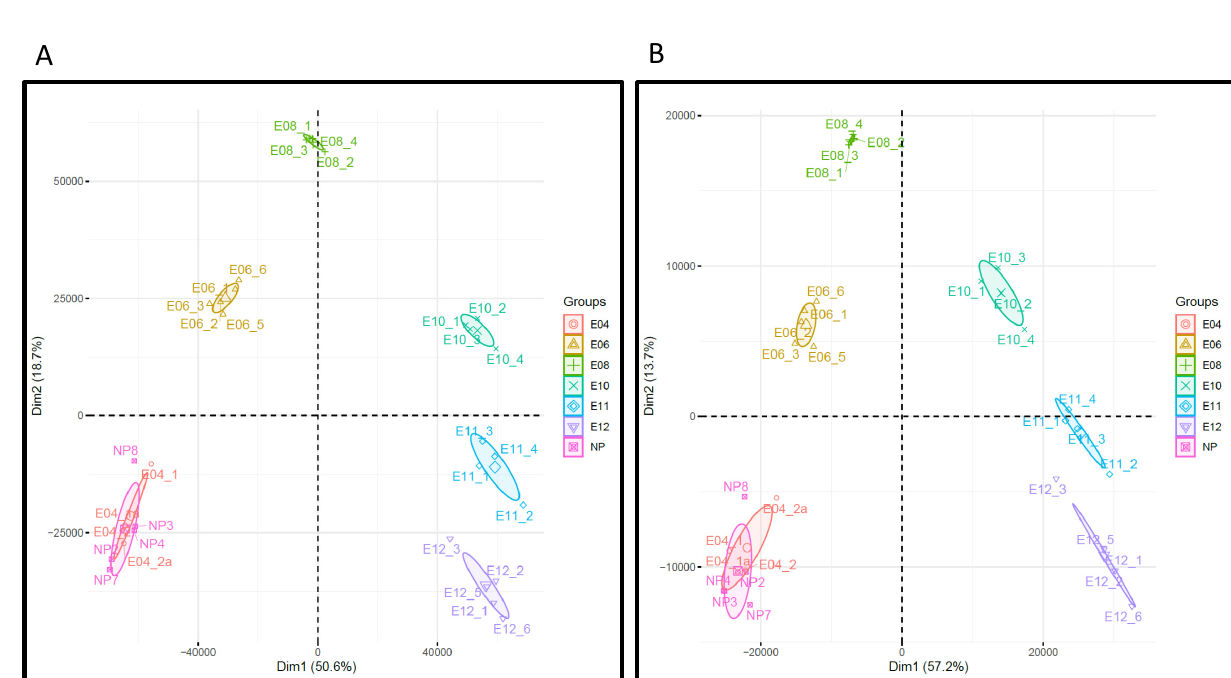
Fig 5. Impact of transcript filtration based on the beta diversity measure. Transcriptome analyses were performed on non-pregnant mice (NP), and at days 4, 6, 8, 10, 11, and 12 post coitum as reported in Nehar-Belaid et al. 2016. Principal component analysis was performed on the original dataset comprising 12,475 transcripts ( A ), and on the decomplexified dataset comprising the 2,161 transcripts obtained based on beta diversity maximization method described ( B ).